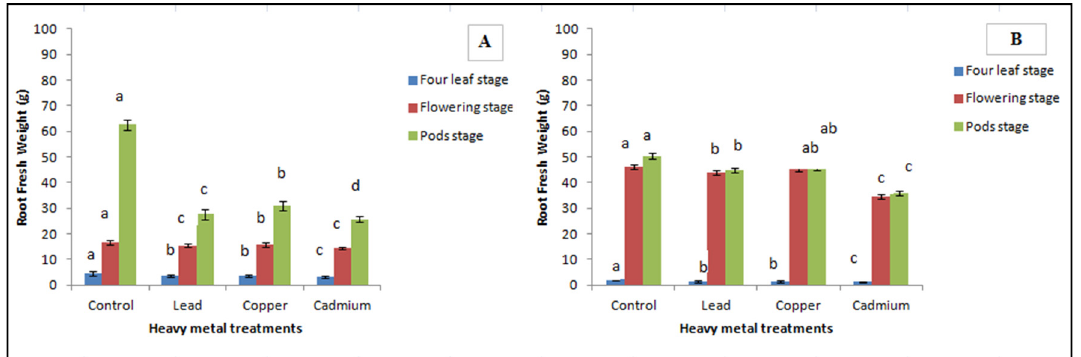
Figure 2. Response of bean plants ( A ) (a, b, c, d) and faba bean plants ( B ) (a, b, c) to HM treatments at different stages of growth, depicted for the fresh weight of the roots.